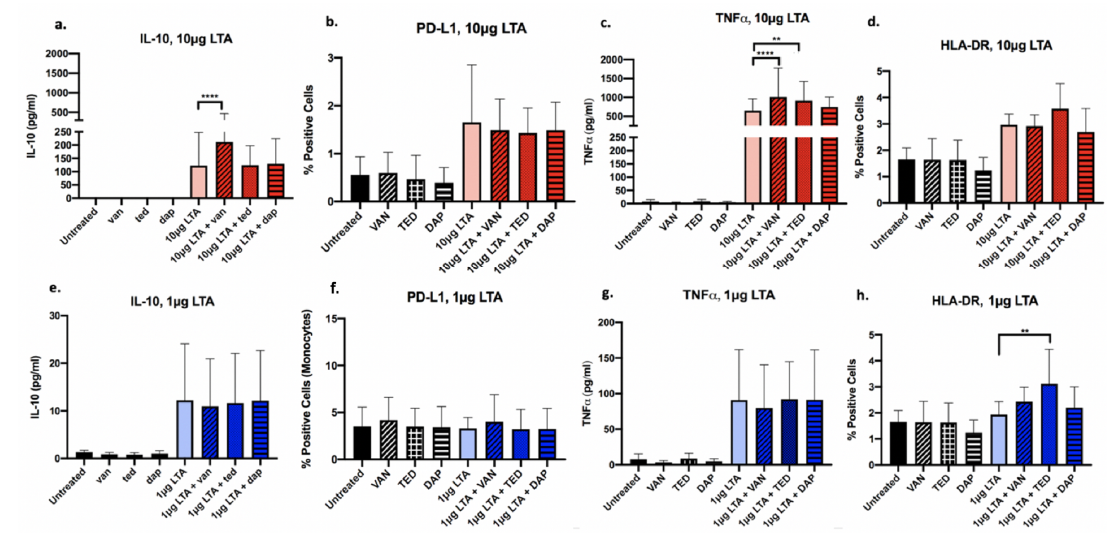
Figure 2. Expression of select immune markers in human PBMCs ( n = 4) exposed to antibiotics and 10 µ g / mL (high) ( a – d ) or 1 µ g / mL (low) ( e – h ) purified S. aureus LTA. Antibiotics include VAN, vancomycin; TED, tedizolid; DAP, daptomycin. Protein expression was determined using either flow cytometry (PD-L1, HLA-DR, TLR2) or ELISA (IL-10, TNFα). Antibiotics alone and untreated cells were used as controls. Data are displayed as means with error bars depicting standard deviation. Brackets indicate statistical comparisons between treatments: ** p < 0.01; **** p < 0.0001.